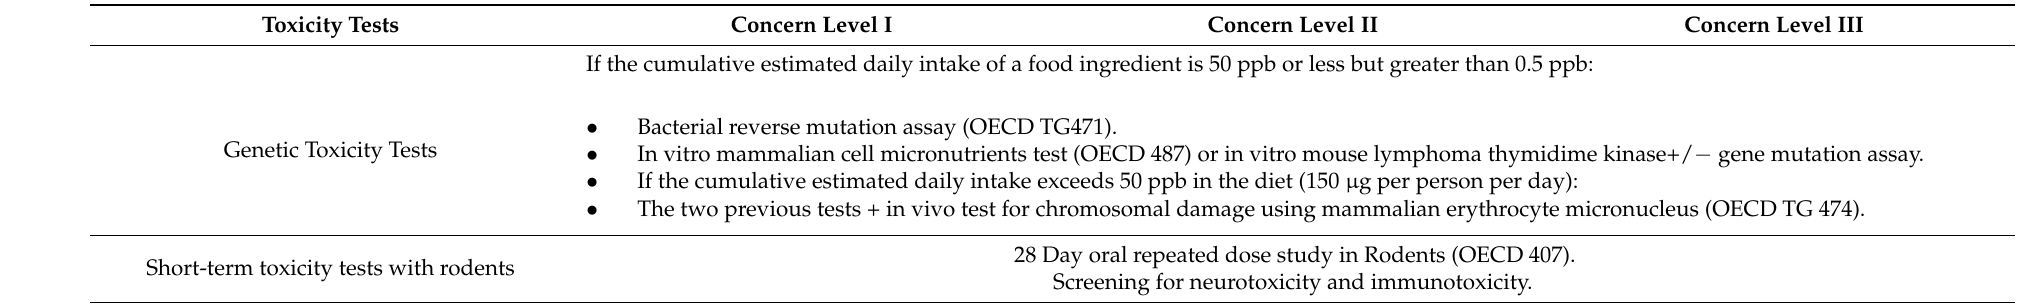
Table 3. Approach suggested by the Food and Drug Administration (FDA) for the toxicity evaluation of food